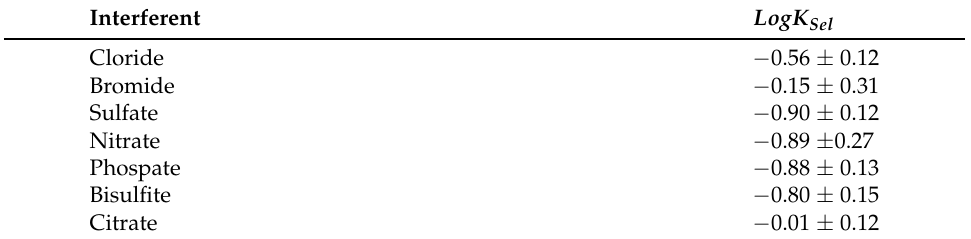
Prim . ion , Interf .